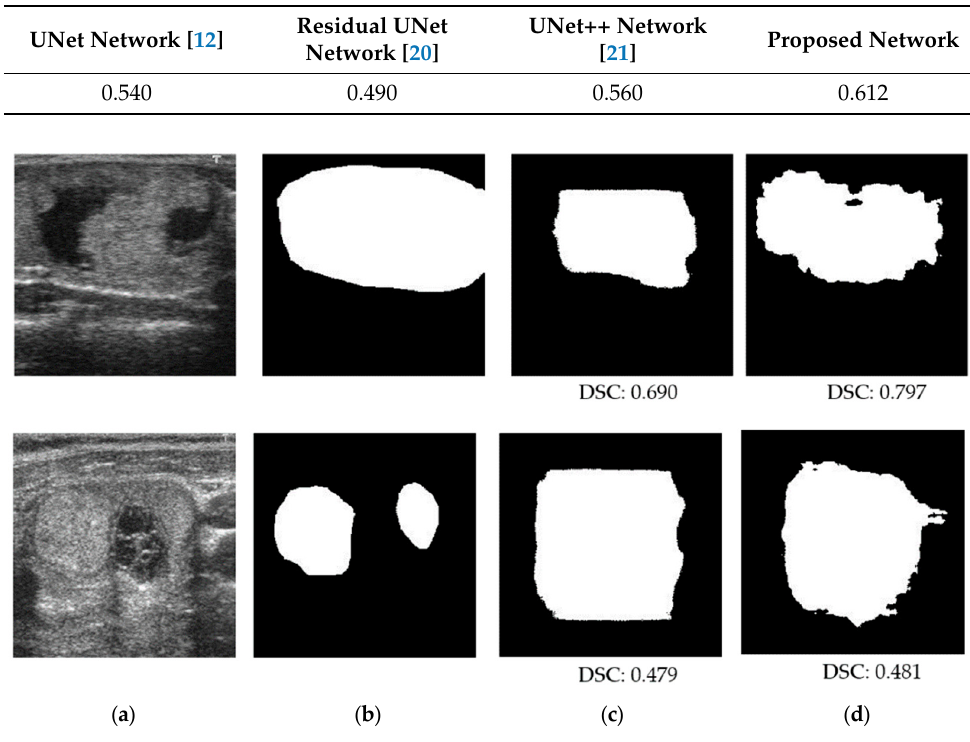
Figure 11. Examples of segmentation result with the TDID dataset: ( a ) input images; ( b ) label images; ( c ) results obtained by UNet network; ( d ) results obtained by the proposed method. Table 8. Comparison of segmentation performance (DSC) between our proposed method and pre- vious study on TDID dataset .